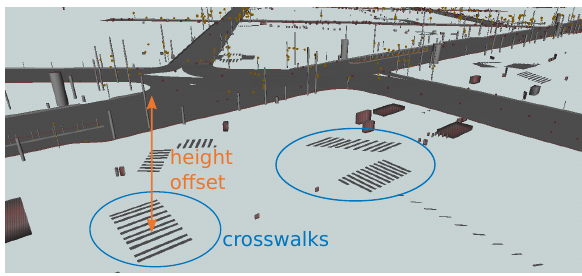
Figure 13. Systematic height offset from the road to unclassified crosswalks objects.